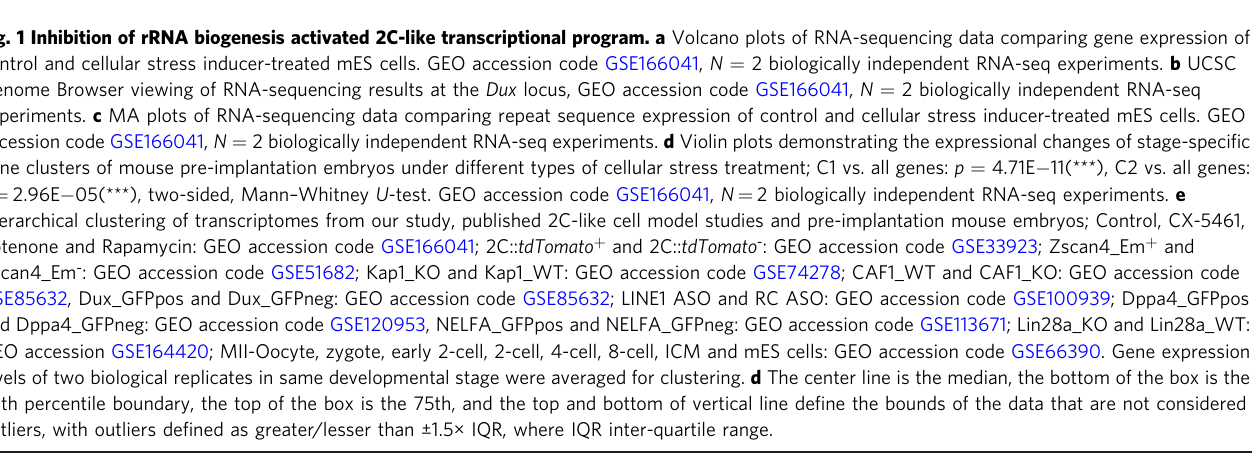
levels of two biological replicates in same developmental stage were averaged for clustering. d The center line is the median, the bottom of the box is the 25th percentile boundary, the top of the box is the 75th, and the top and bottom of vertical line de fi ne the bounds of the data that are not considered outliers, with outliers de fi ned as greater/lesser than ±1.5× IQR, where IQR inter-quartile